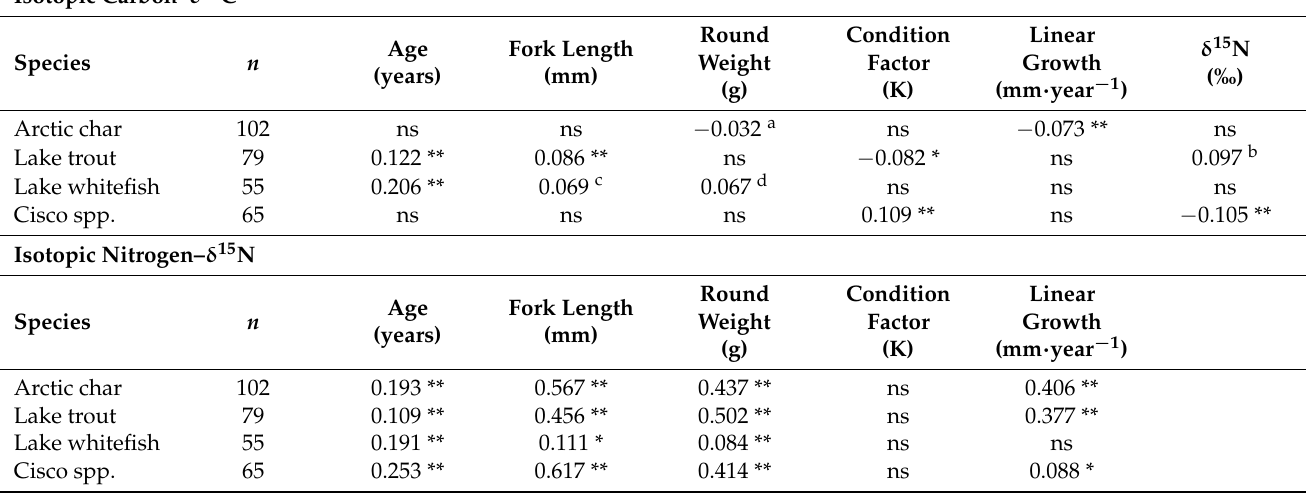
Table 5. Coefficient of determination (r 2 ) showing the proportion of variation in carbon and nitrogen isotopic concentrations in muscle tissue in relation to age, fork length, body weight, condition, and linear growth, and showing statistical significance of the regressions (with negative relationships indicated by minus signs), noting that several coefficients provided were not significant but approached significance—these and probability levels are referenced by superscripts and provided as